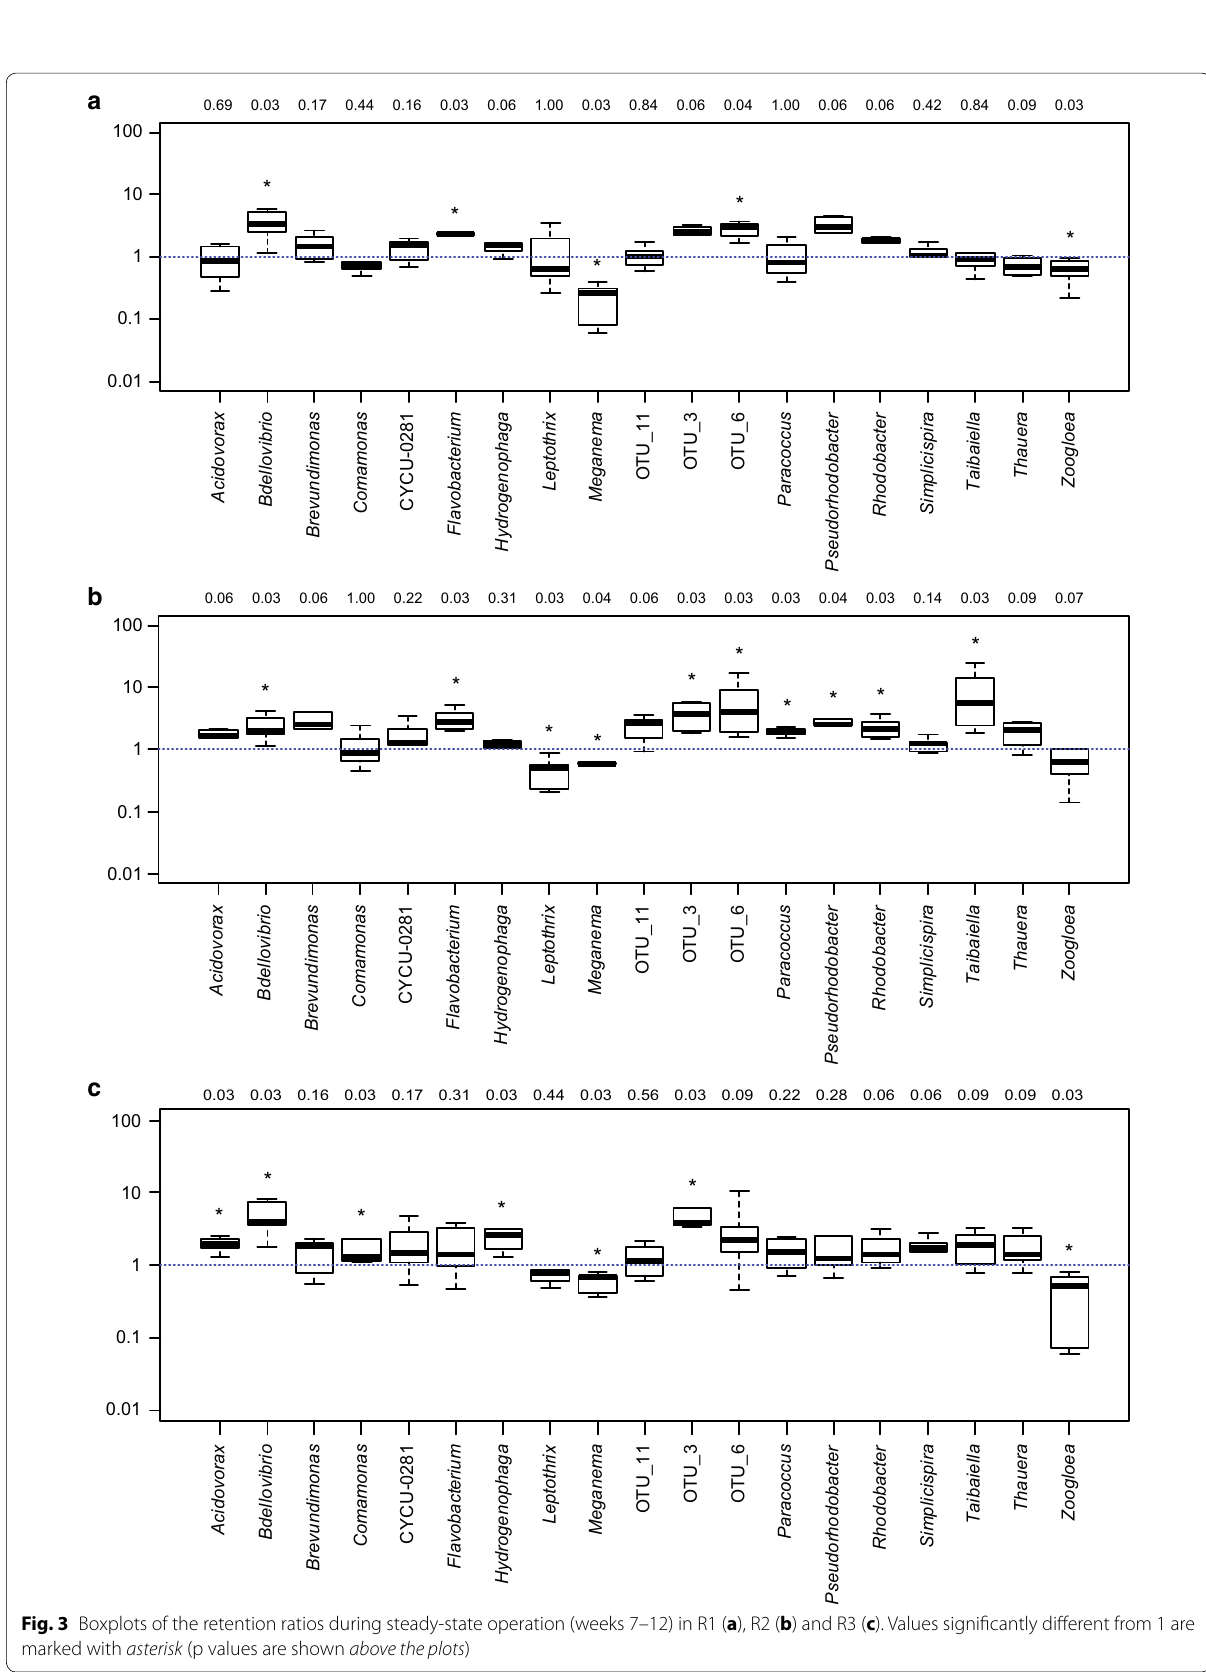
Fig. 3 Boxplots of the retention ratios during steady‑state operation (weeks 7–12) in R1 ( a ), R2 ( b ) and R3 ( c ). Values significantly different from 1 are marked with asterisk (p values are shown above the plots